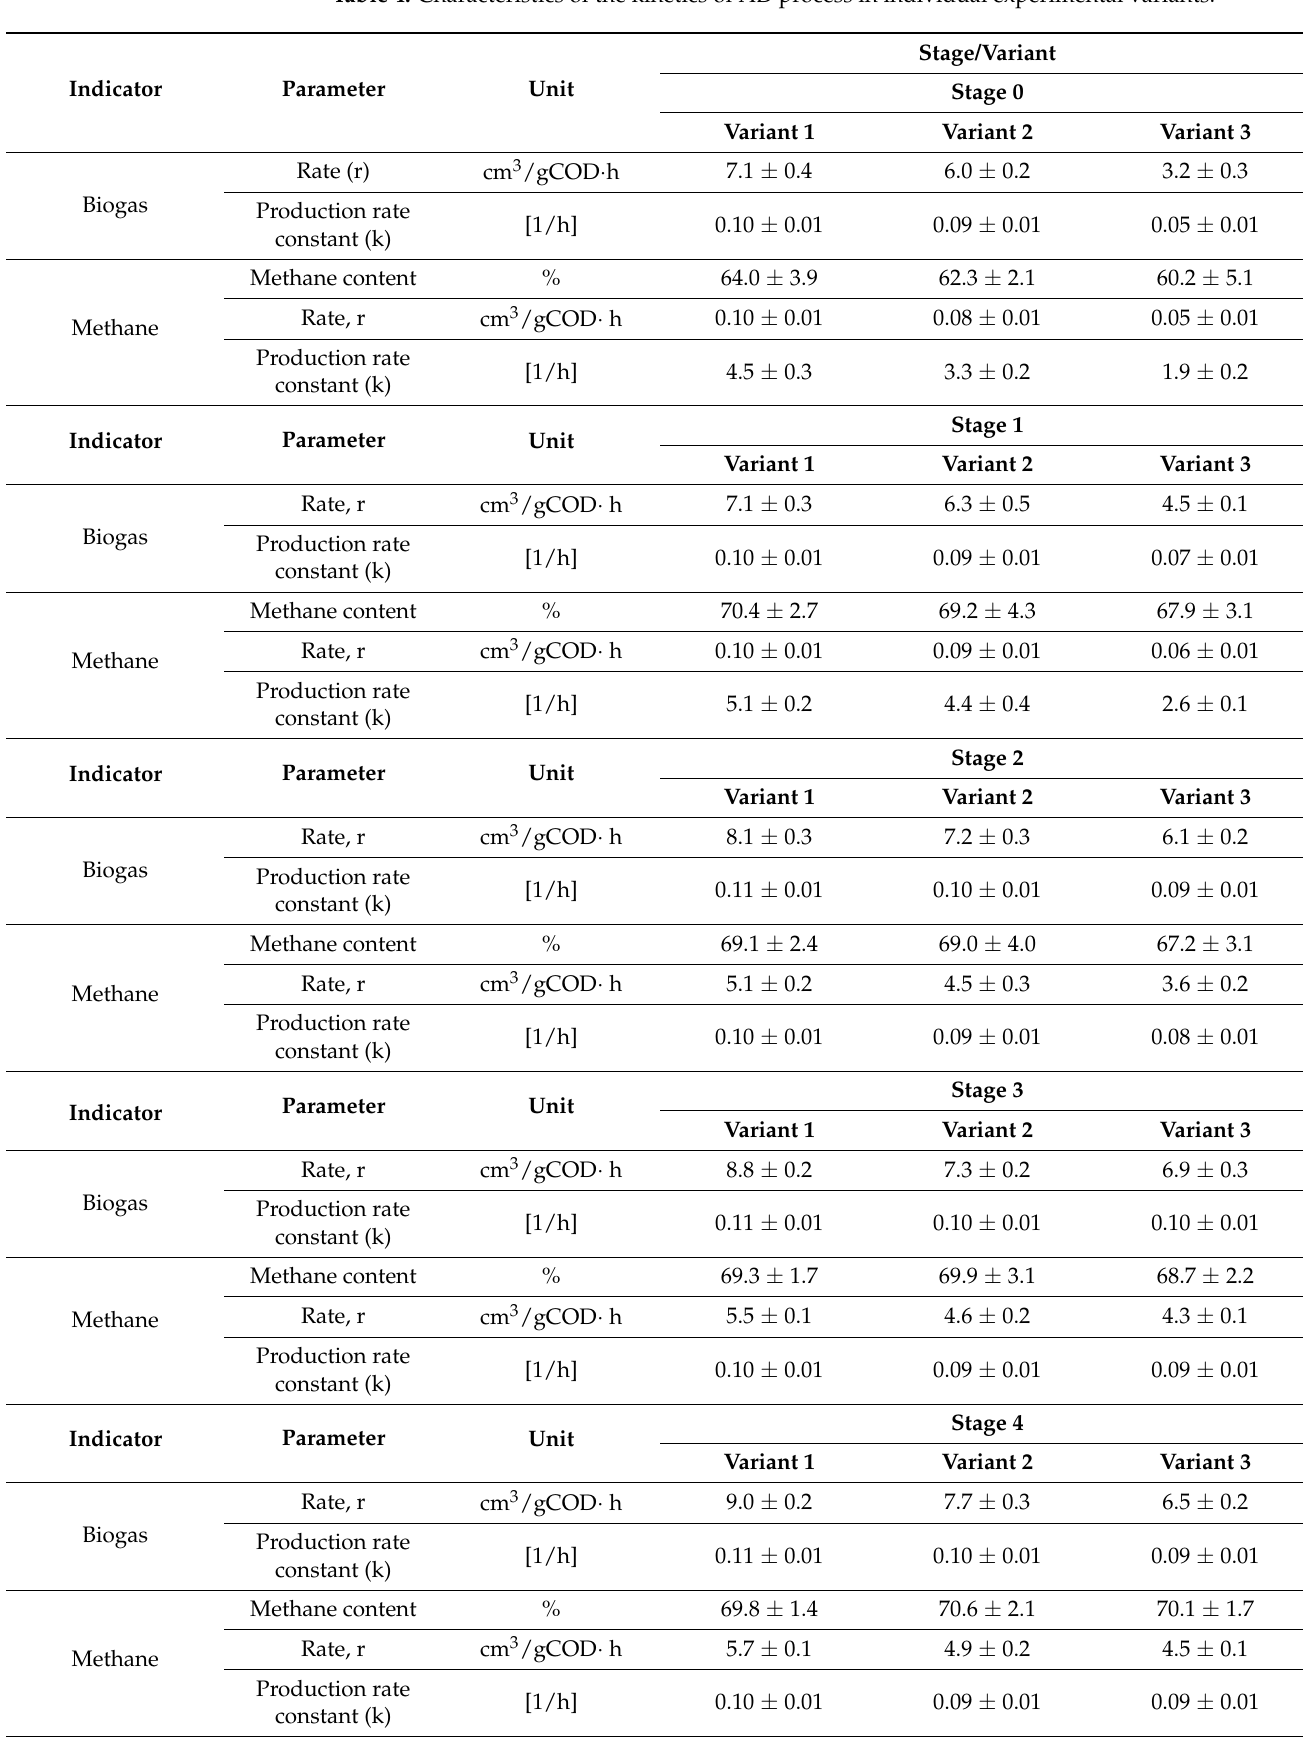
Table 4. Characteristics of the kinetics of AD process in individual experimental